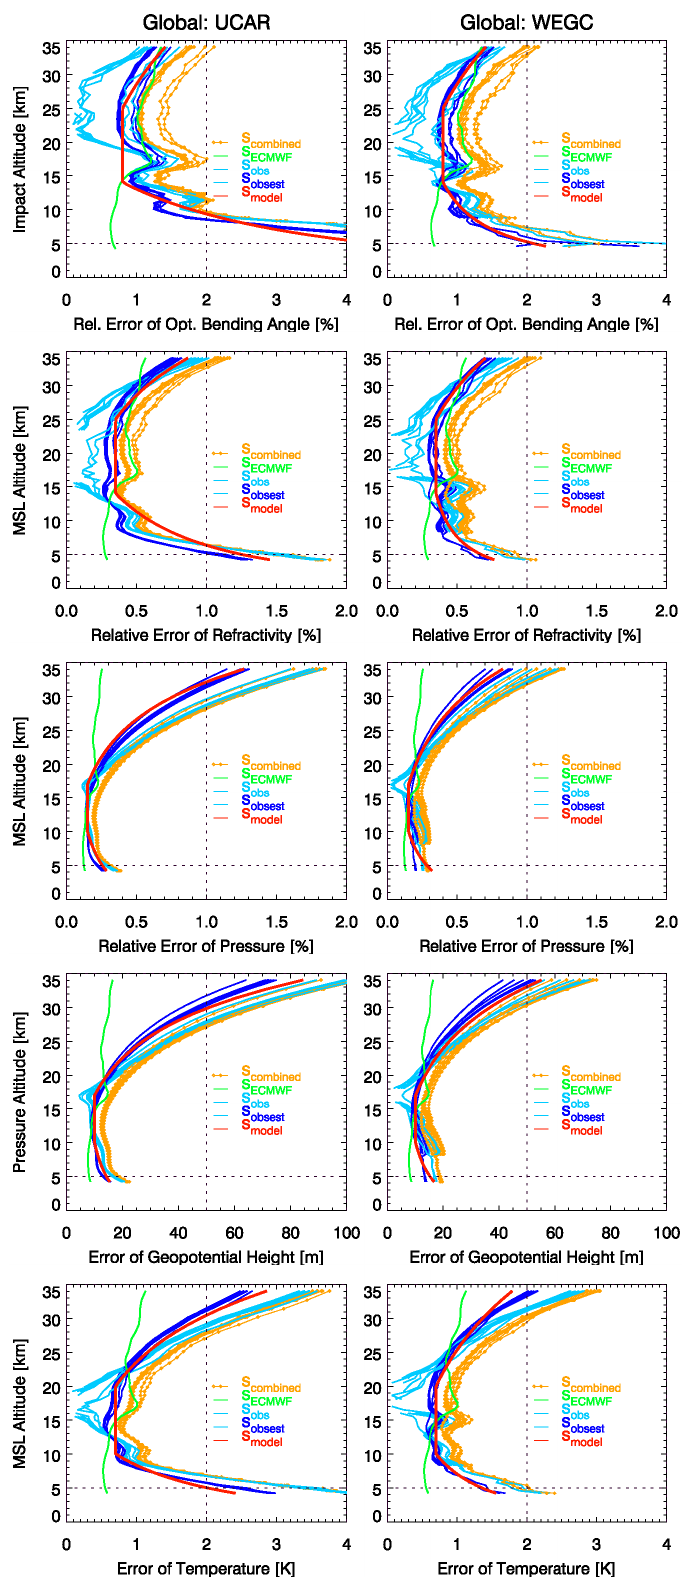
Fig. 8. Global UCAR (left panels) and WEGC (right panels) error estimates for optimized bending angle, refractivity, dry pressure, dry geopotential height, and dry temperature in July